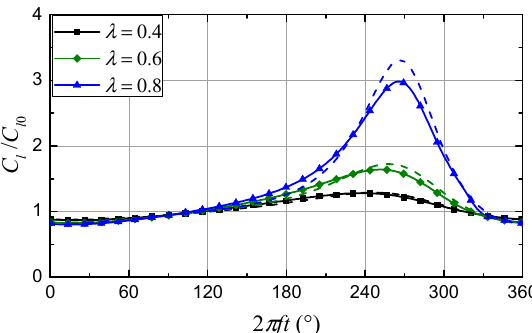
Figure 6. Unsteady lift coefficient of the NREL S809 airfoil at different amplitudes of velocity variation. C l 0 is the quasi-steady lift coefficient at V 0 . Solid lines denote the URANS results, and dashed lines the theoretical results.